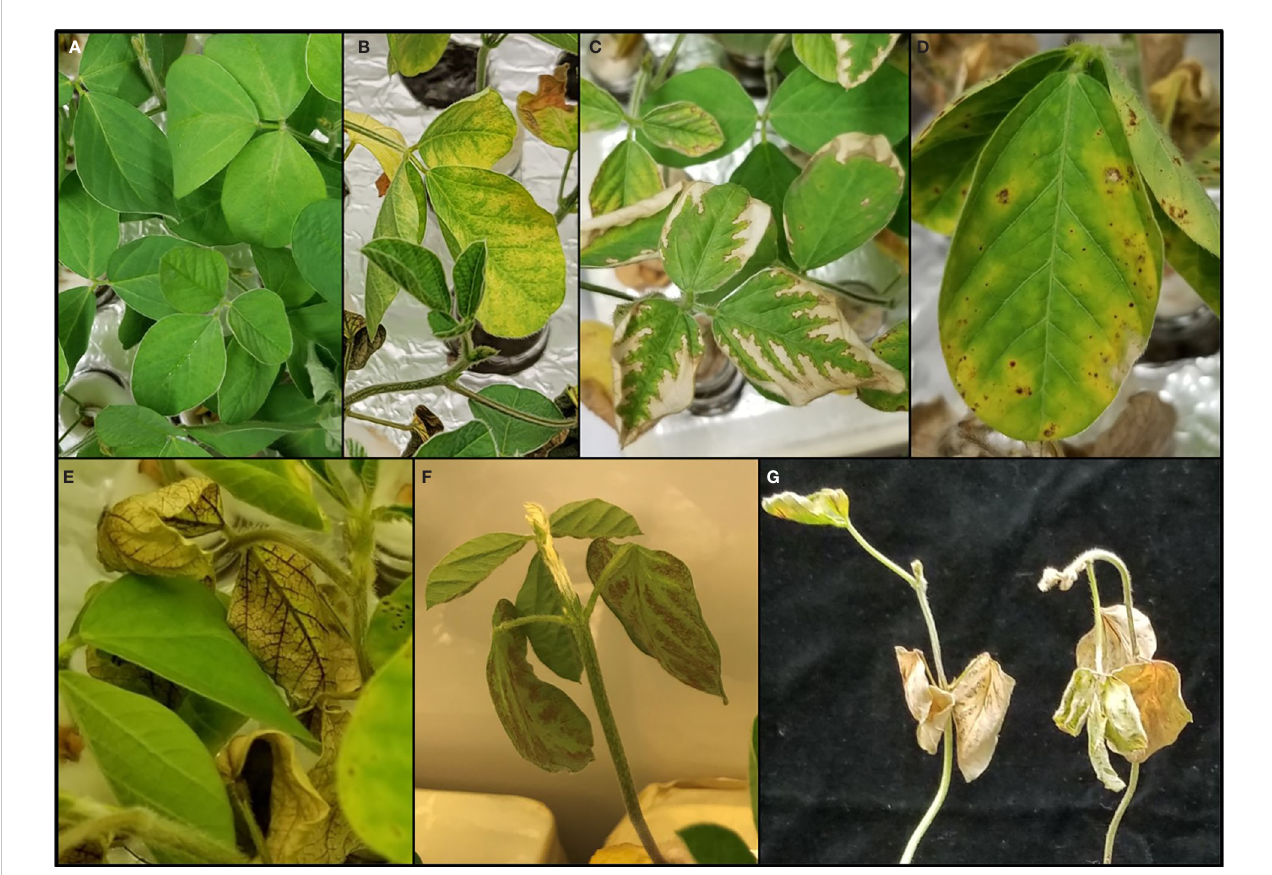
FIGURE 1 Effects of various toxins produced by Macrophomina phaseolina on soybean seedling foliage. The responses from the experiment ranged from no phytotoxic effect, as shown in the healthy plant control (A) , to the following phytotoxic responses: chlorosis (B) , photobleaching (C) , necrosis (D) , vascular discoloration (E) , intervascular discoloration (F) , and death (G)